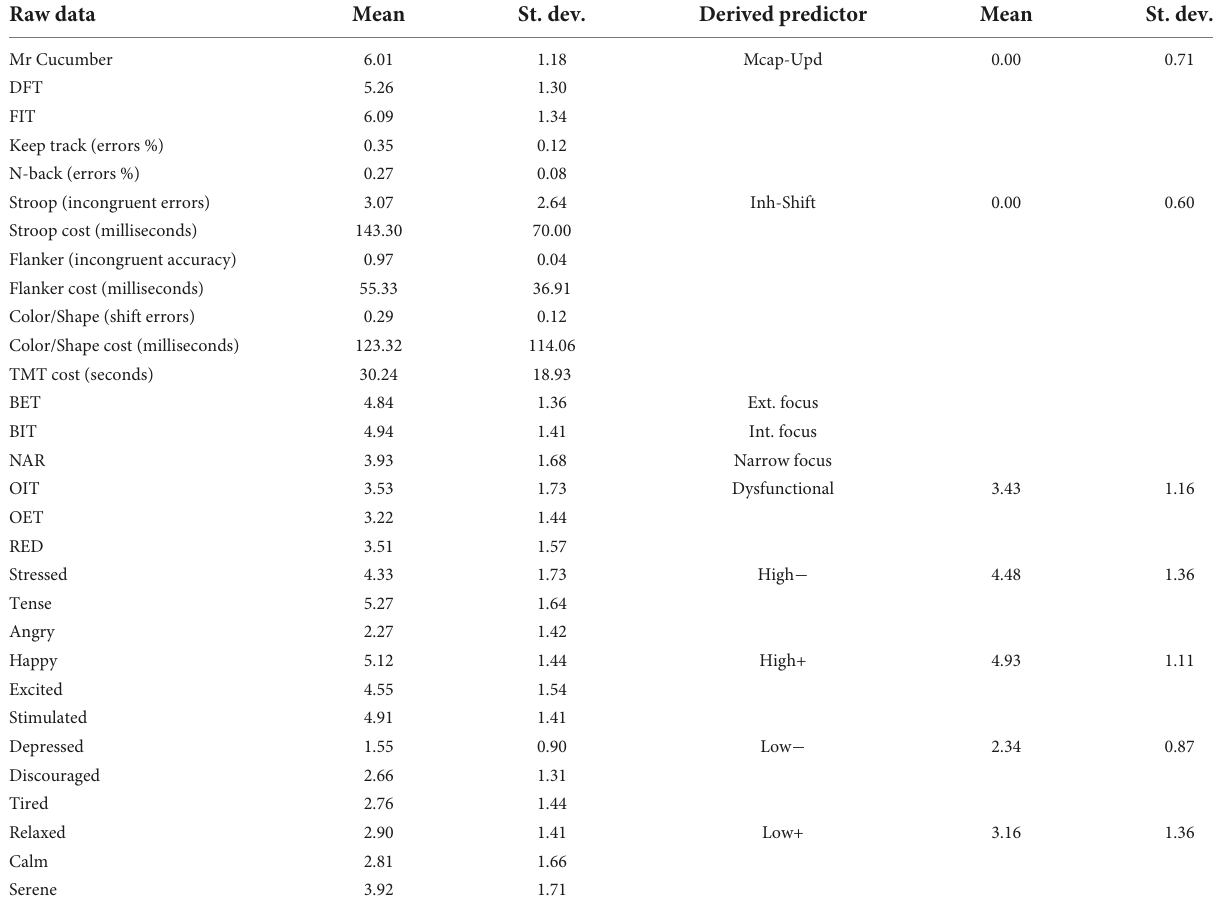
TABLE 4 Observed variables and derived predictors descriptive